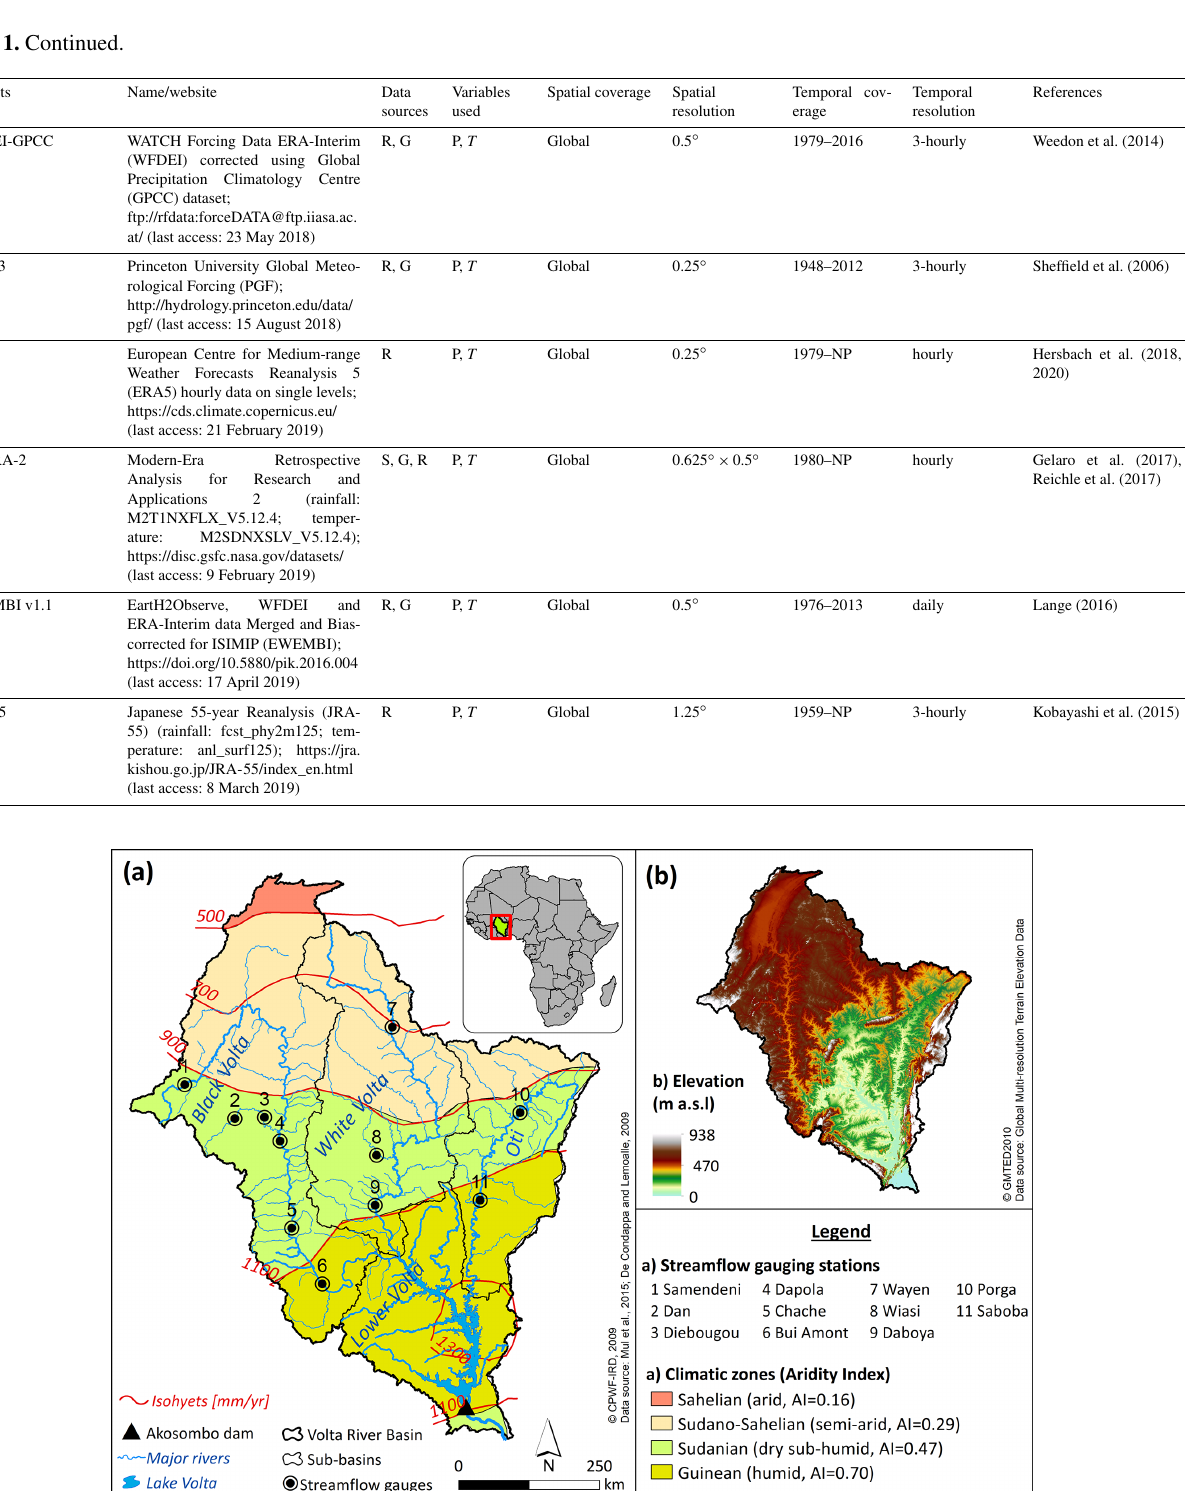
Figure 2. Physical and hydroclimatic characteristics of the Volta River basin. (a) shows the hydrographic network and the climatic zones, and (b) shows the digital elevation model. The mean aridity index (AI) of each eco-climatic zone is derived from the global aridity index database (Trabucco and Zomer,